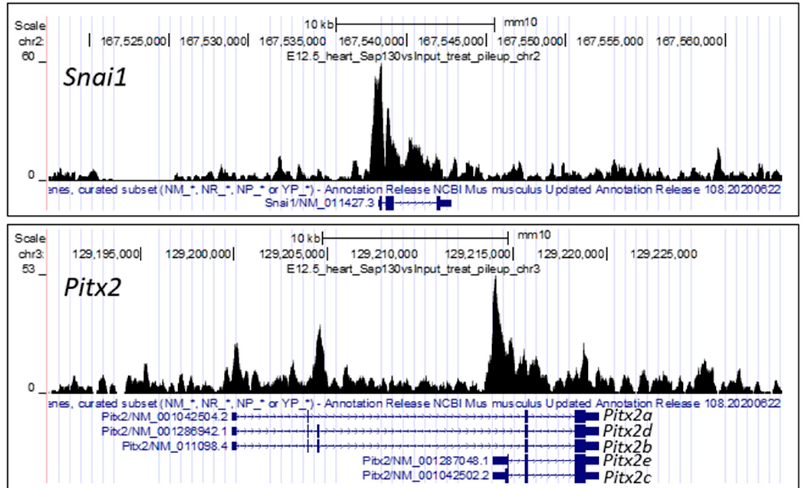
Figure 2. Sap130 ChIP–seq of E12.5 mouse heart. Sap130 antibody was used for chromatin immunoprecipitation sequencing, identifying Sap130 occupancy over the promoter regions of left–right patterning genes Snai1 and Pitx2 . It should be noted fir Pitx2 , transcripts for three isoforms are shown, Pitx2a , b , c , d , e. Pitx2c is the isoform associated with left–right patterning.